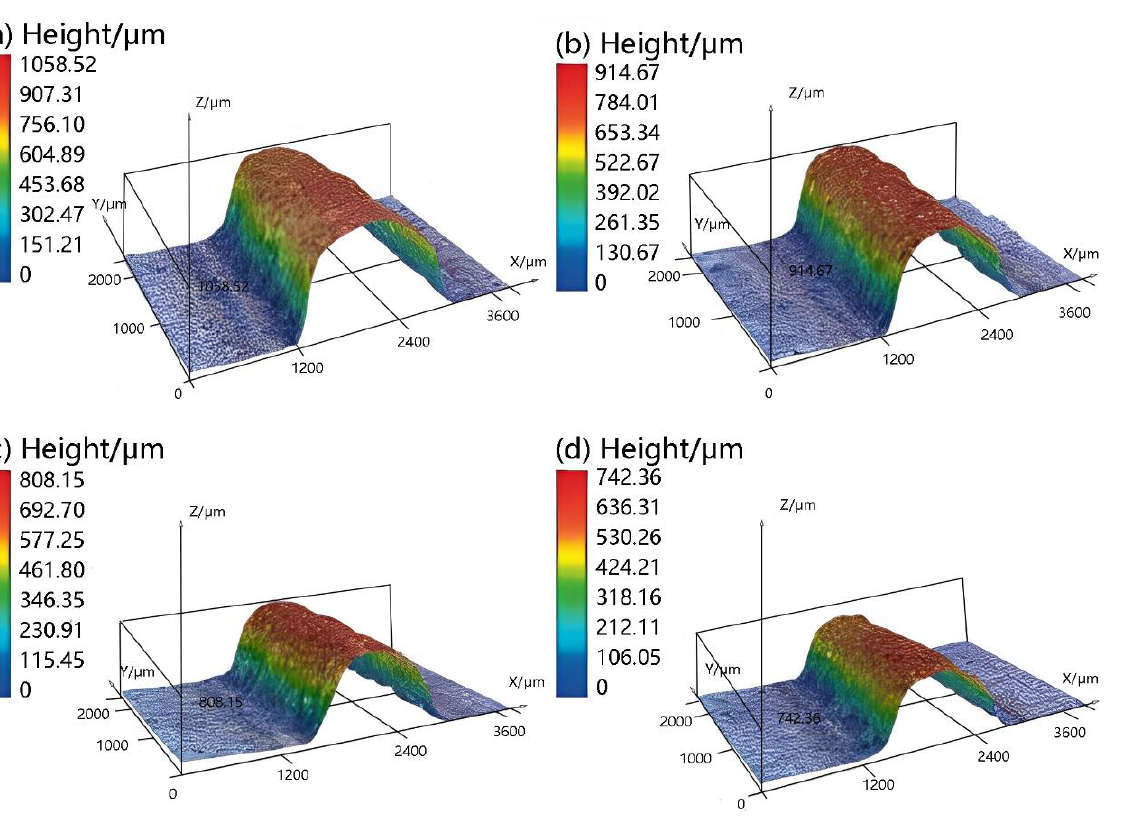
( b ) Figure 9. Deposition channel size under different laser power. ( a ) Sedimentary channel height varies with scanning speed; ( b ) Sedimentary channel width varies with scanning speed. The model developed in this study is used to compute the form of the deposited layer by altering the powder feeding rate and the laser power parameters. The relative error between the simulation results and the experimental findings does not surpass 8%, prov- ing the model ’ s dependability in both cases. 4.2. Temperature Field Characteristics of Single-Channel Deposition As depicted in Figure 10, the temperature field distribution of the single-channel IN718 deposited layer at various times was determined using simulation calculations of the process with a powder feeding rate of 0.2 g/s, laser power of 500 W, and a scanning speed of 10 mm/s. Within 0.05 s of the start of the process, the shape of the deposited layer